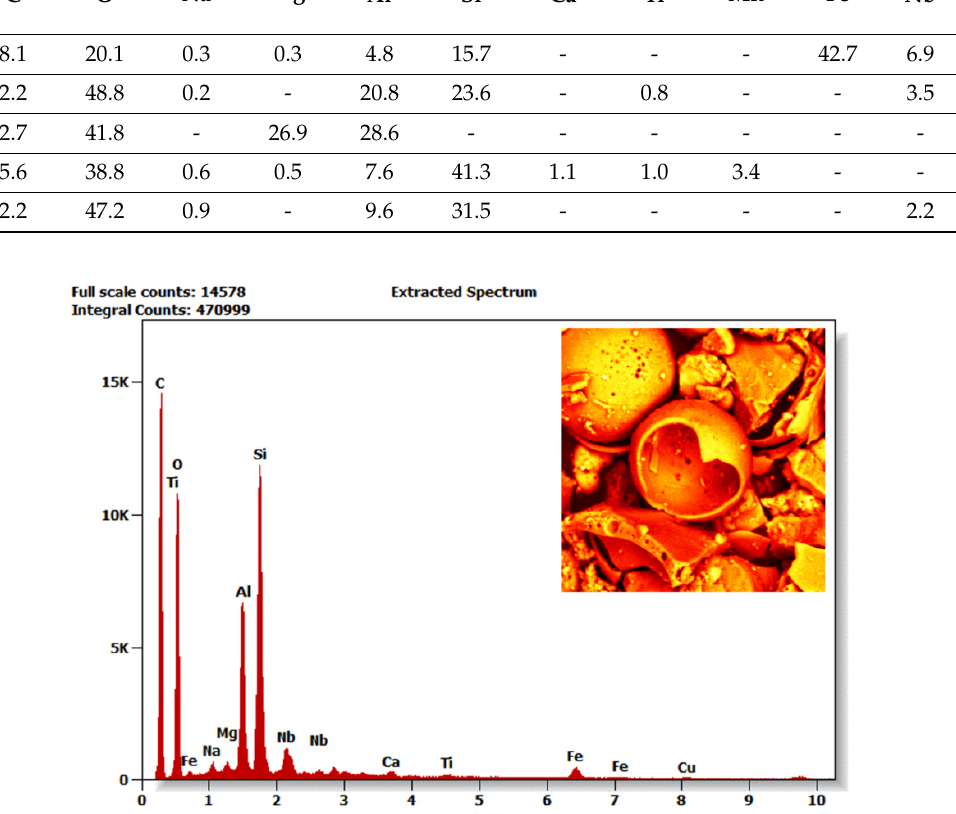
Figure 10. EDS spectra for CS F_45 fraction (energy: 20 keV).